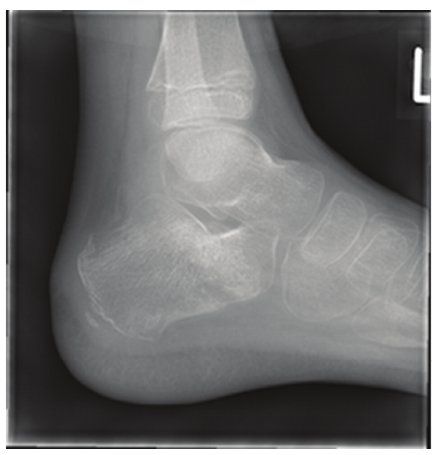
Figure 6: Lateral radiograph at eight-weeks review showing com- plete bony